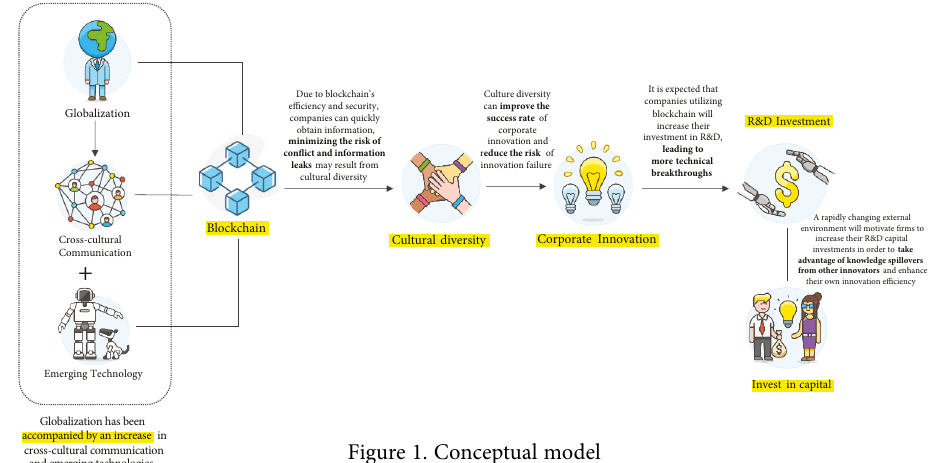
Figure 1. Conceptual